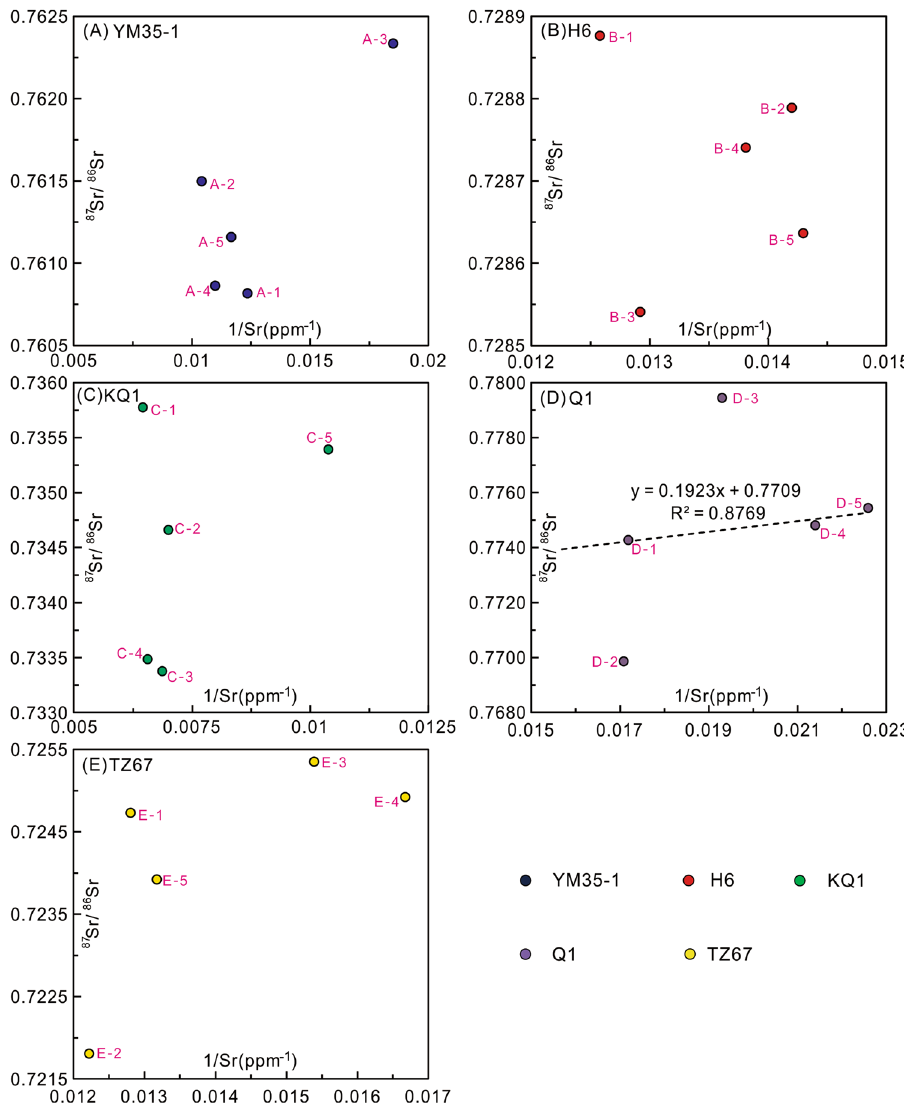
Figure 7. Scatter plots of 87 Sr/ 86 Sr vs 1/Sr ratios. ( A ) YM35-1; ( B ) H6; ( C ) KQ1; ( D ) Q1. The black dashed line is the regression of subsamples D-1, D-4 and D-5; ( E )